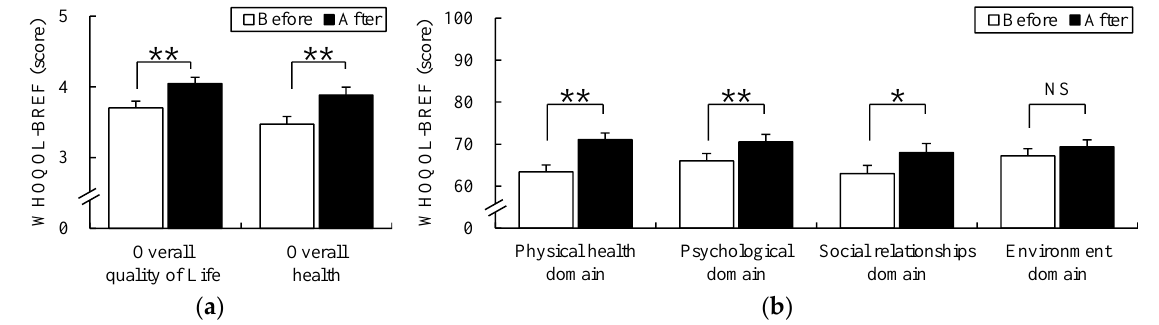
Figure 6. Changes in scores of WHOQOL-BREF before and after the FCA ( a ) The individual’s overall perception of quality of life and health. ( b ) The four domains (physical health, psychological health, social relationships, environment health) of WHOQOL-BREF. Data are presented as mean ± standard error ( n = 61). Significance was verified by the Wilcoxon signed-rank test; NS = not significant, * p < 0.05, ** p < 0.01.